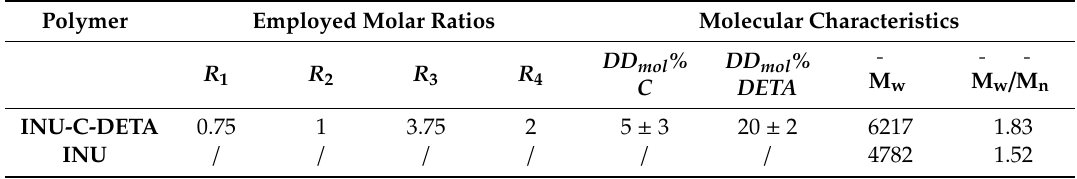
Table 1. Summary of reaction conditions and characterization data of INU-C-DETA.